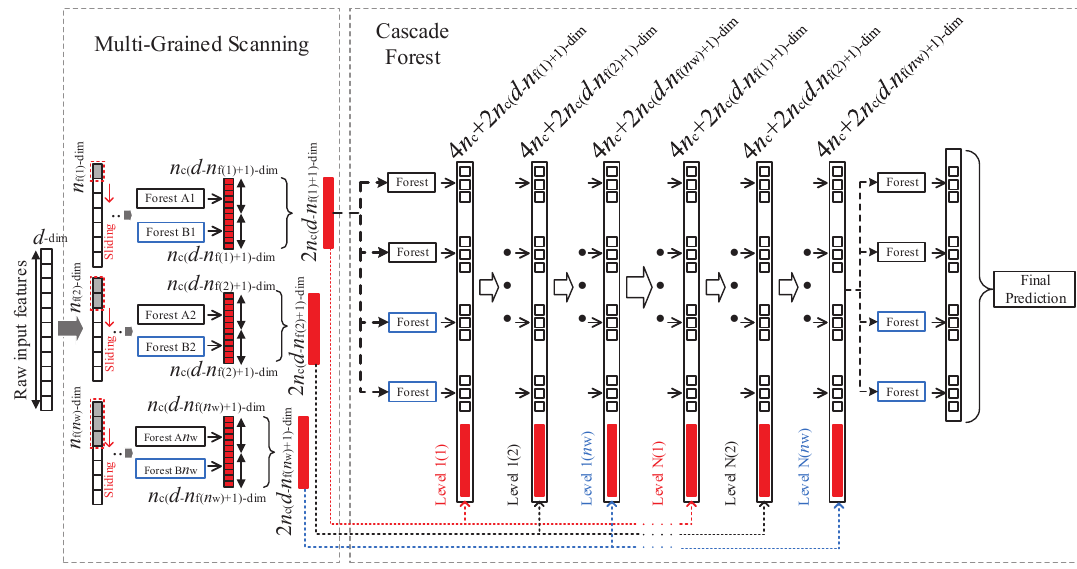
Figure 2. Deep forest